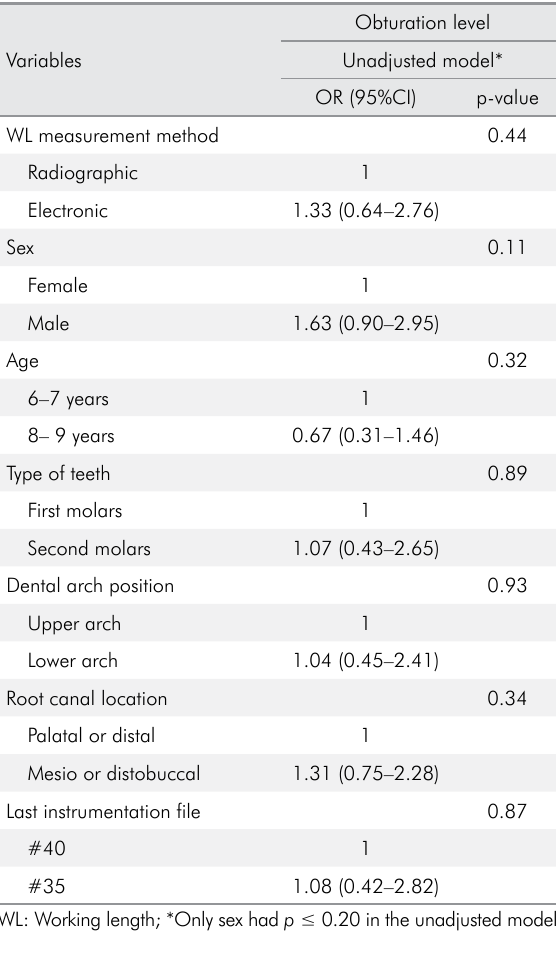
Table 2. Unadjusted repeated measures logistic regression model for the obturation level and possible associated variables (n =